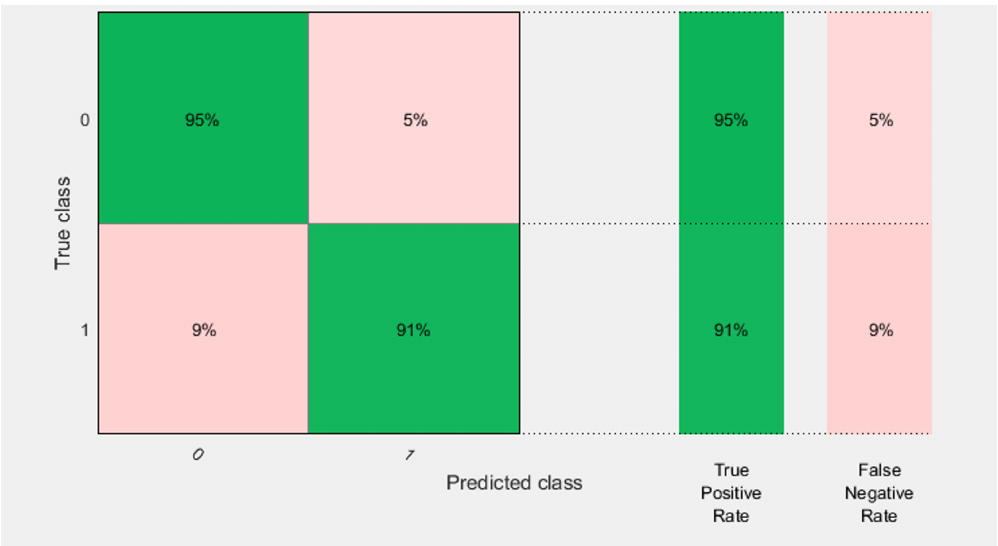
Figure 16. Confusion matrix of EMG measured from biceps brachii muscle bagged tree